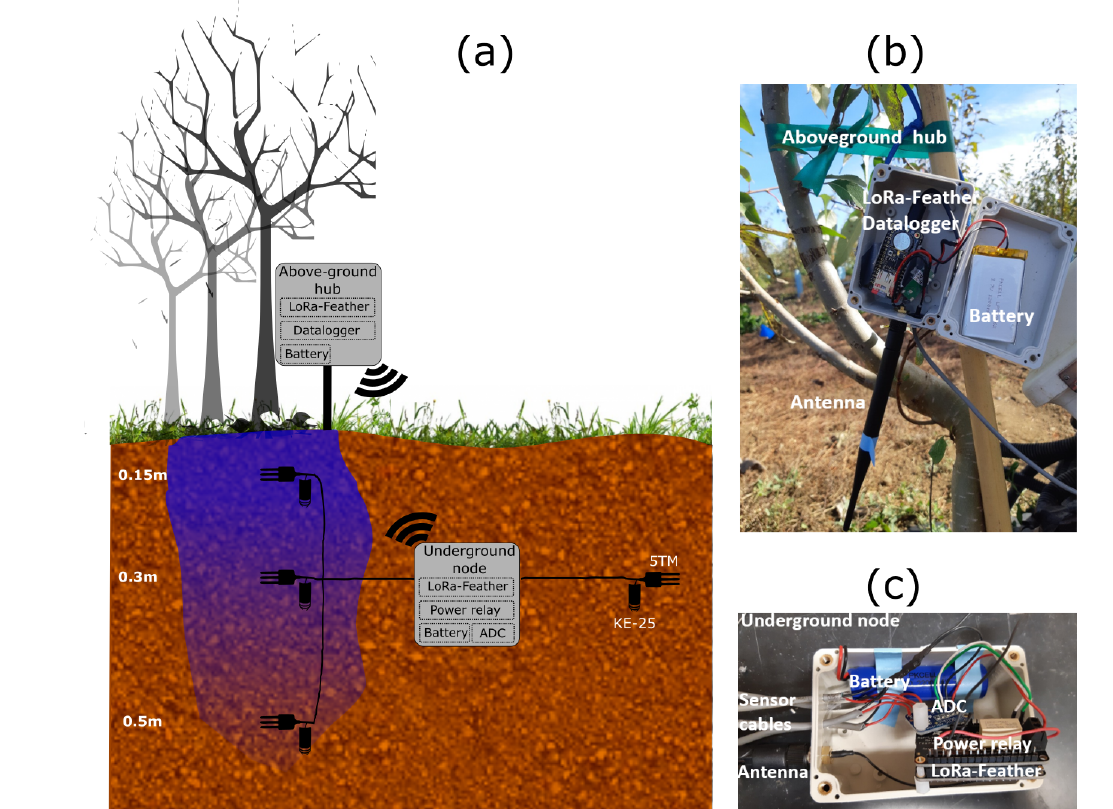
Figure 1. Scheme of the LoRa-WUSN experimental set-up in the field (a) , the components of the above-ground hub (b) , and the underground node before coating (c)